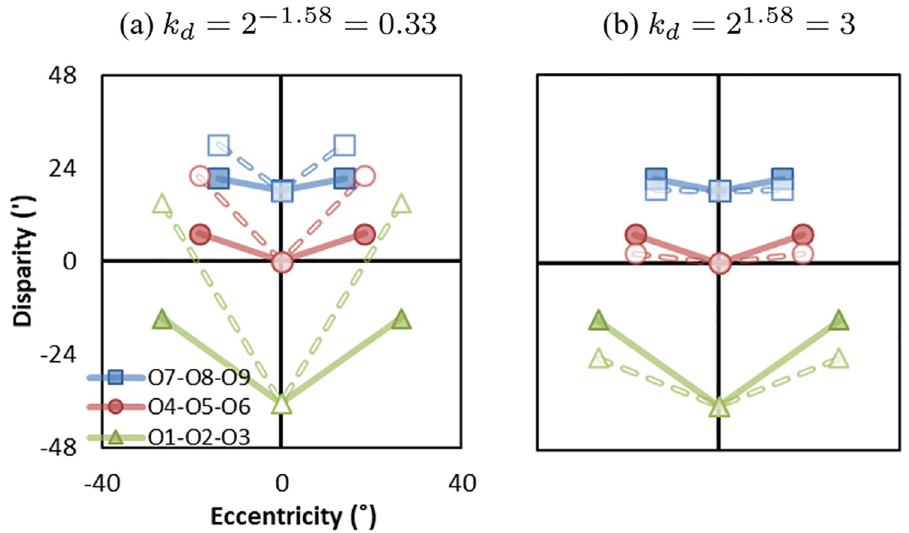
= 3). Solid lines represent the eccentricity-disparity in the d